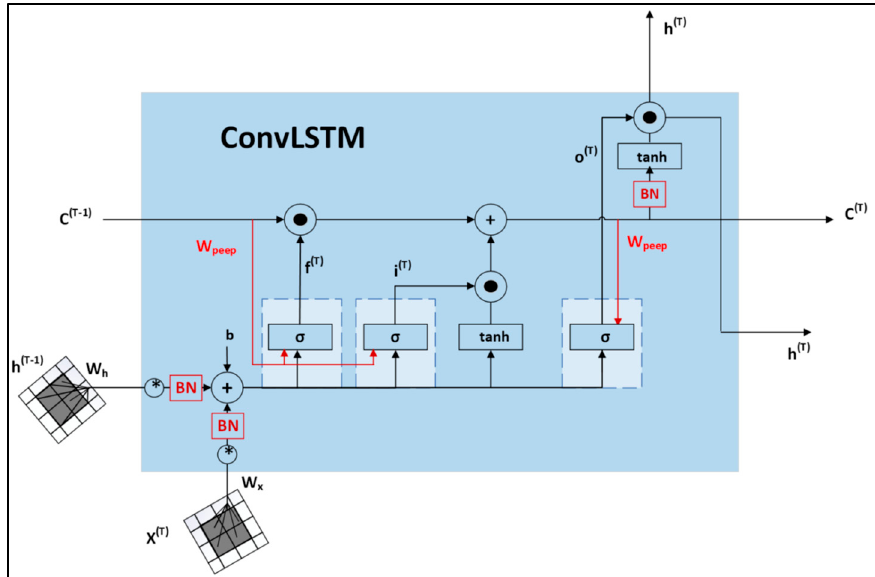
Figure 3 . Structure of ConvLSTM [41]